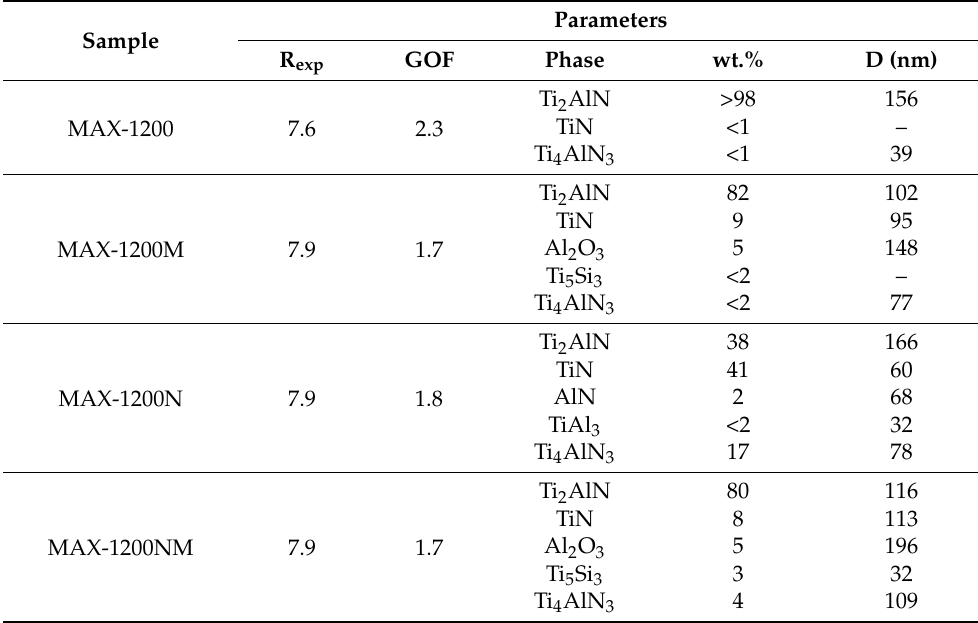
Table 1. Quantitative analysis of phases obtained by the Rietveld and the quality refinement parame- ters. GOF: goodness of fit; D: crystallite